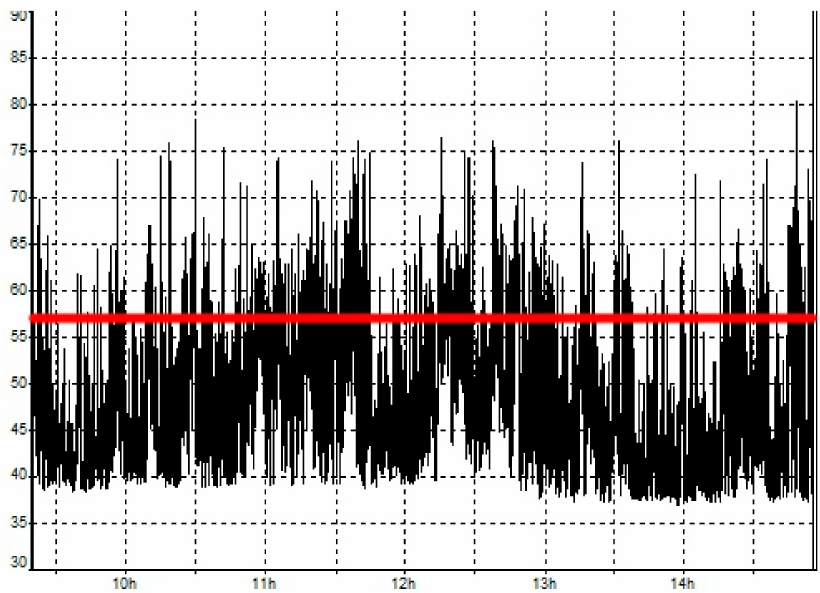
Figure 7. Environmental noise measured in the case study office (Figure 3) in the time slot 9:30–15:00 (L Aeq = 57 dB(A))